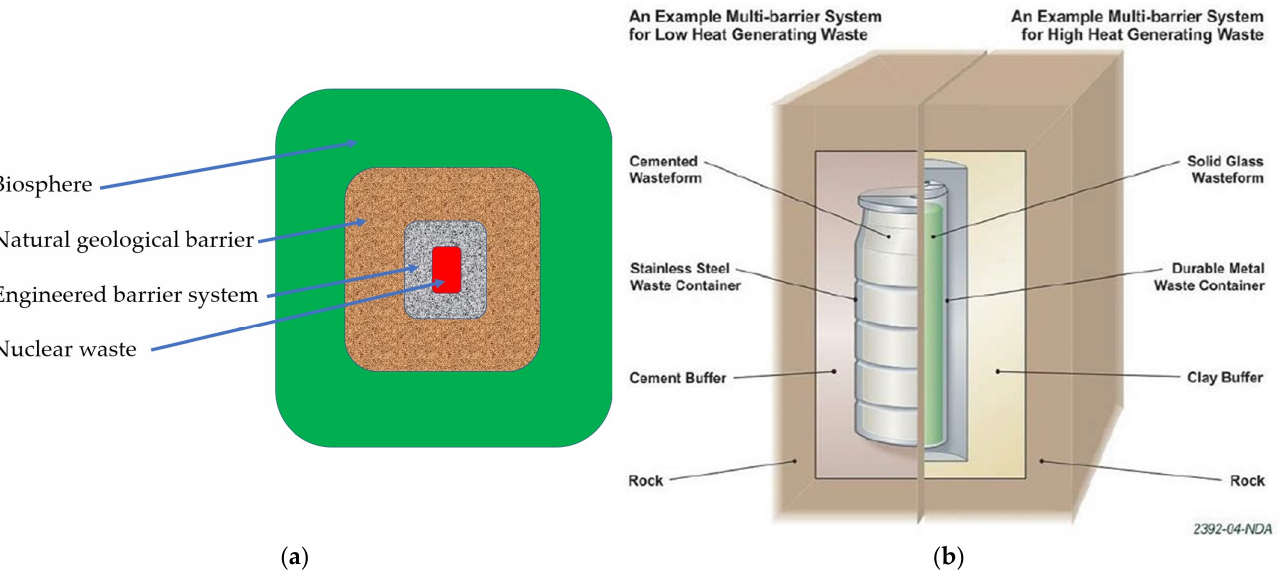
Figure 6. Schematic of multi-barrier system in nuclear waste disposal: ( a ) the two main barrier systems—engineered barrier system (EBS) and natural geological barrier (NGB); ( b ) the UK Nuclear Decommissioning Authority (NDA) example (courtesy of NDA, Moor Row, England, UK). Reproduced with permission of the IAEA from [11].